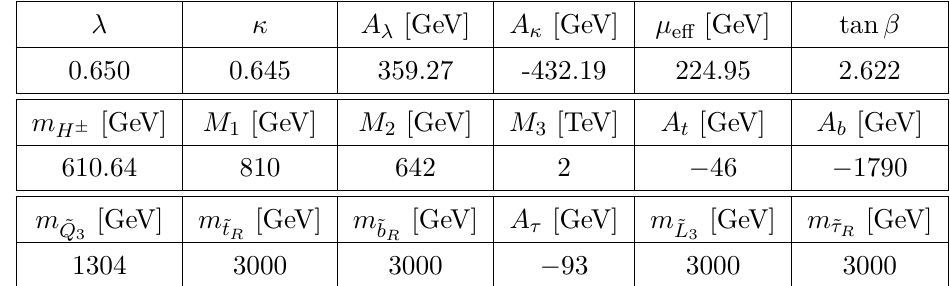
Table 17 . BP10 NMSSM input parameters required by NMSSMCALC for the computation of the NMSSM spectrum. Lower: additional double and single Higgs production related information.